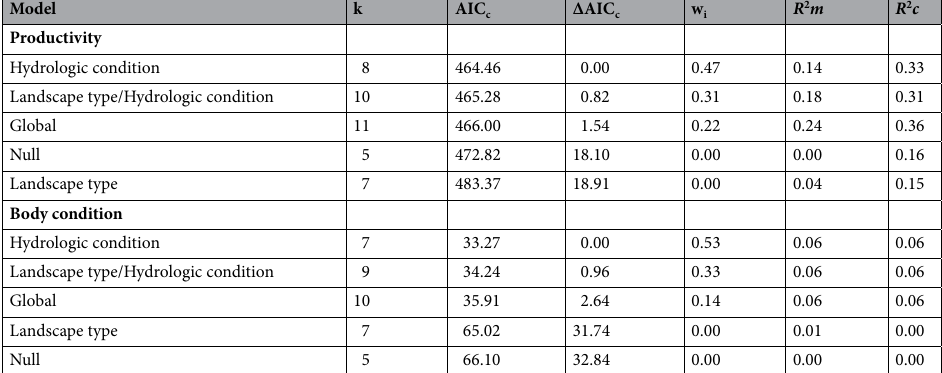
Table 1. Results of generalized mixed models for productivity and body condition of storks, 2015–2017, South Florida. Models are described with number of parameters (k), AIC c values, differences in AIC c values between the best model and each candidate model (∆AIC c ), AIC c weights (w i ), the marginal R 2 ( R 2 m incorporates variance explained by fixed factors), and conditional R 2 ( R 2 c ; incorporates variance explained by both fixed and random factors).